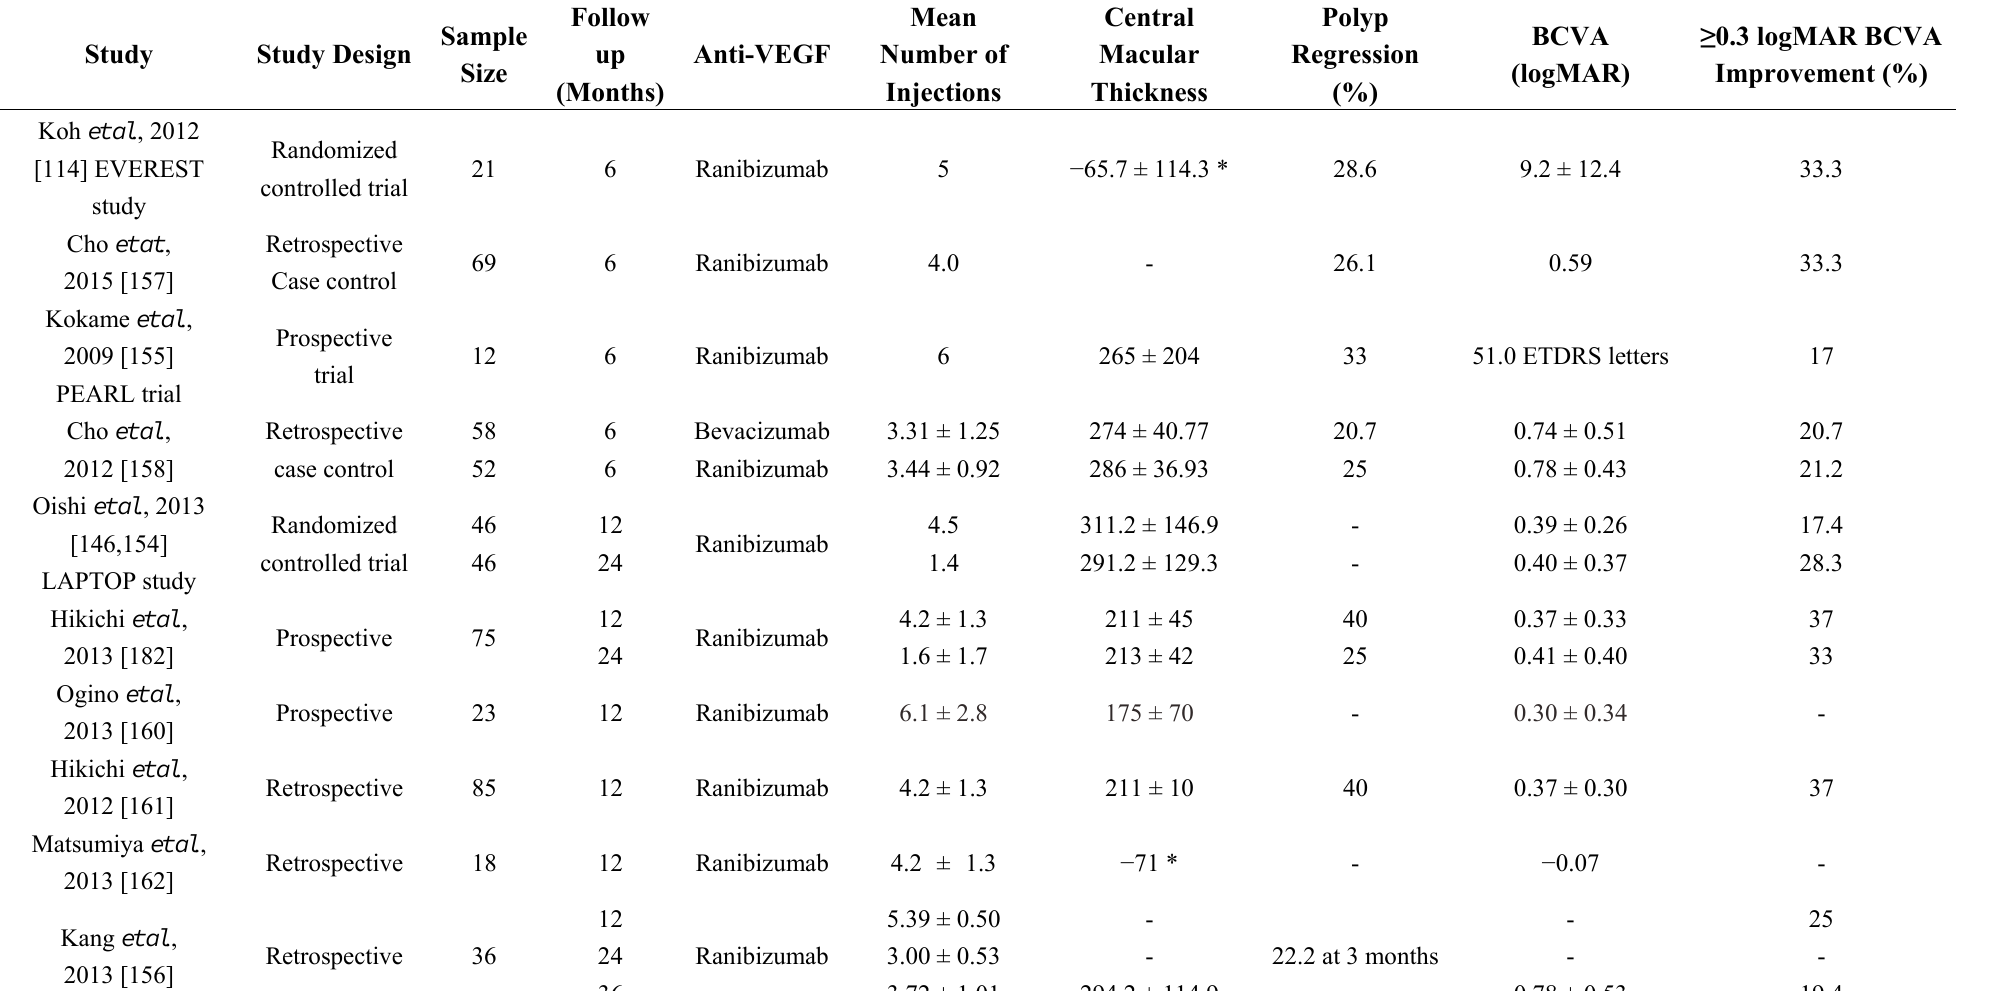
Table 2. Anti-VEGF monotherapy for treatment naïve